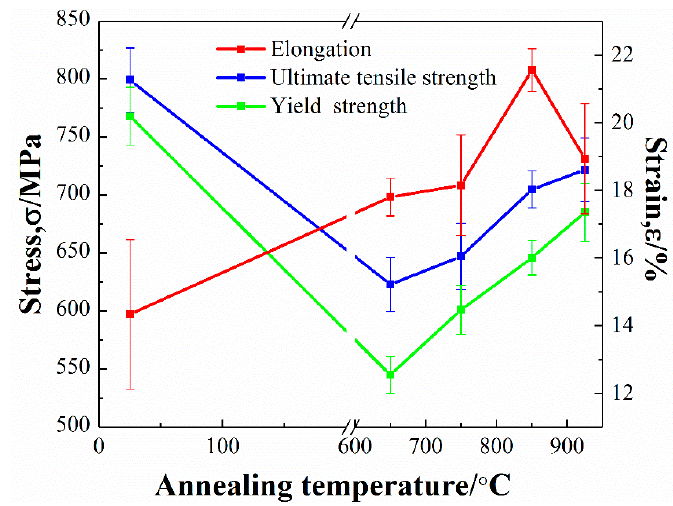
Figure 12. Stress-strain curves of Ti–26Nb alloys after annealing at different temperatures.